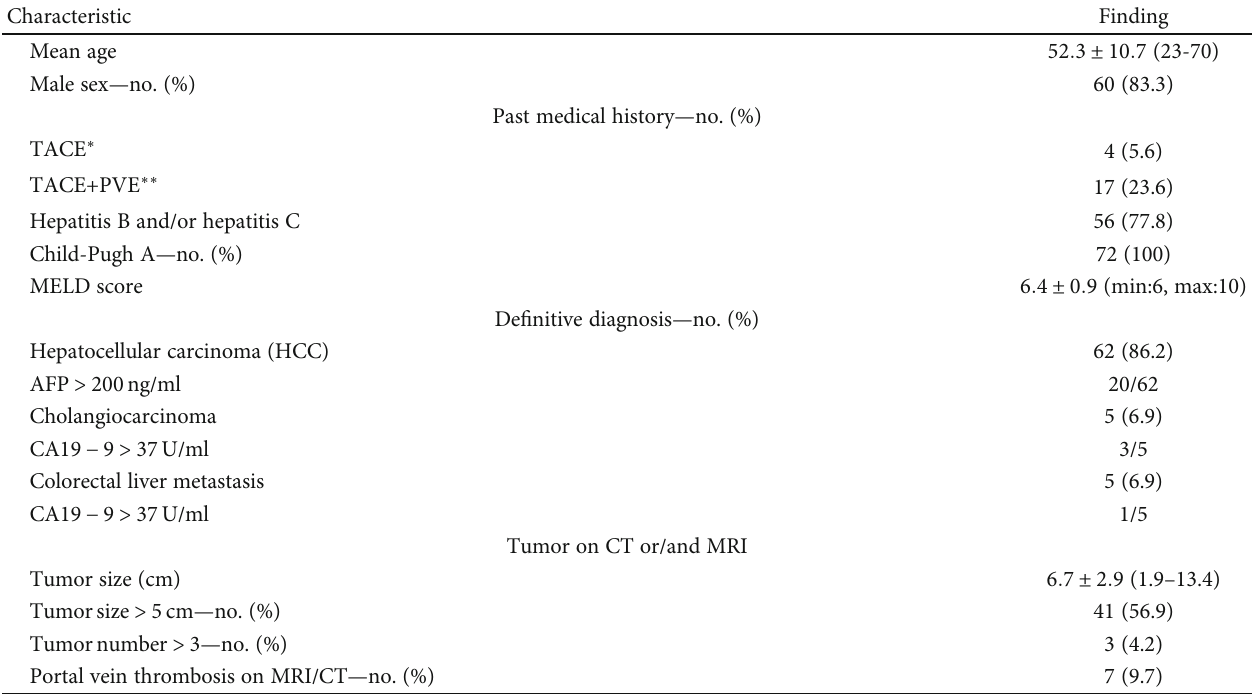
Figure 8: (a) Segment 5 and 6 resection; (b) anterior sectionectomy; (c) segment 5, 6, and 7 resection; (d) left liver plus segment 1 resection and lymphadenectomy. Table 1: Preoperative characteristics of